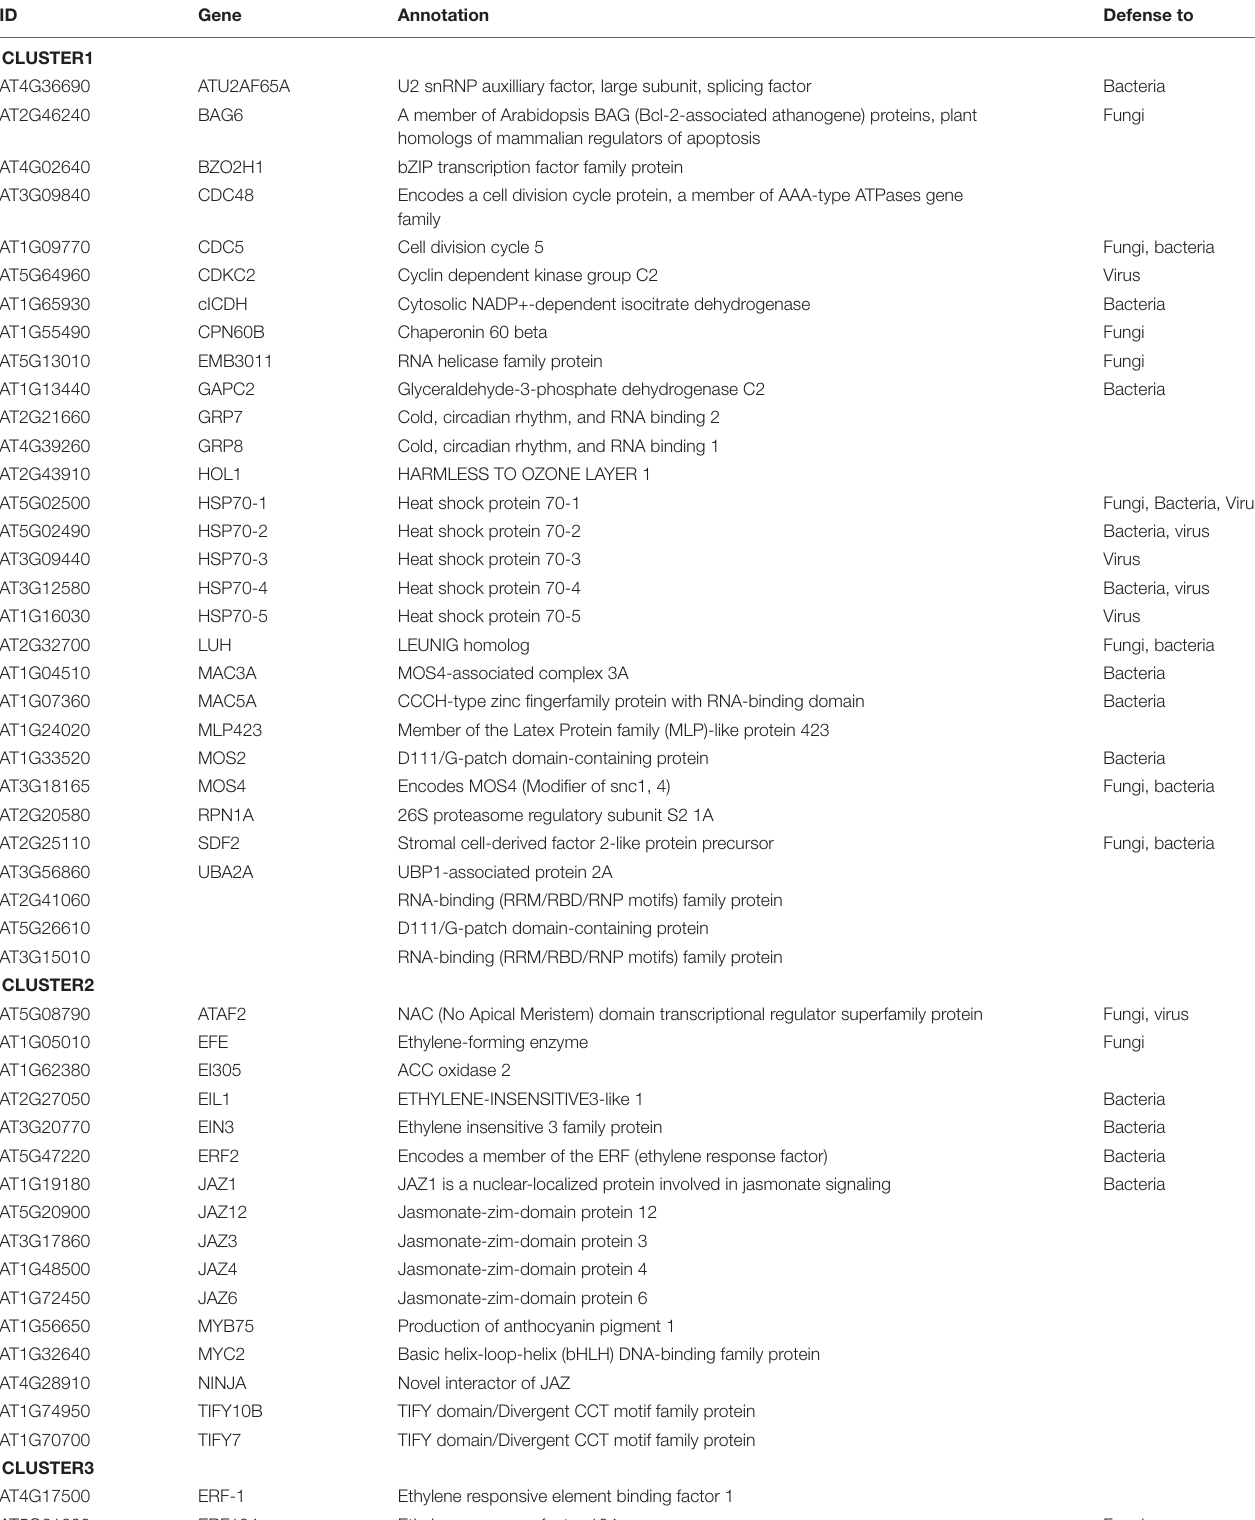
TABLE 2 | List of gene contained in the interactome clusters. ID Gene